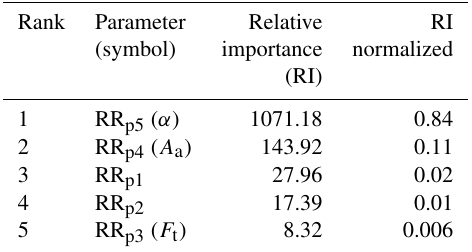
Table 4. Rainfall retrieval sensitivity analysis: RR p n – rainfall re- trieval parameters; see Table